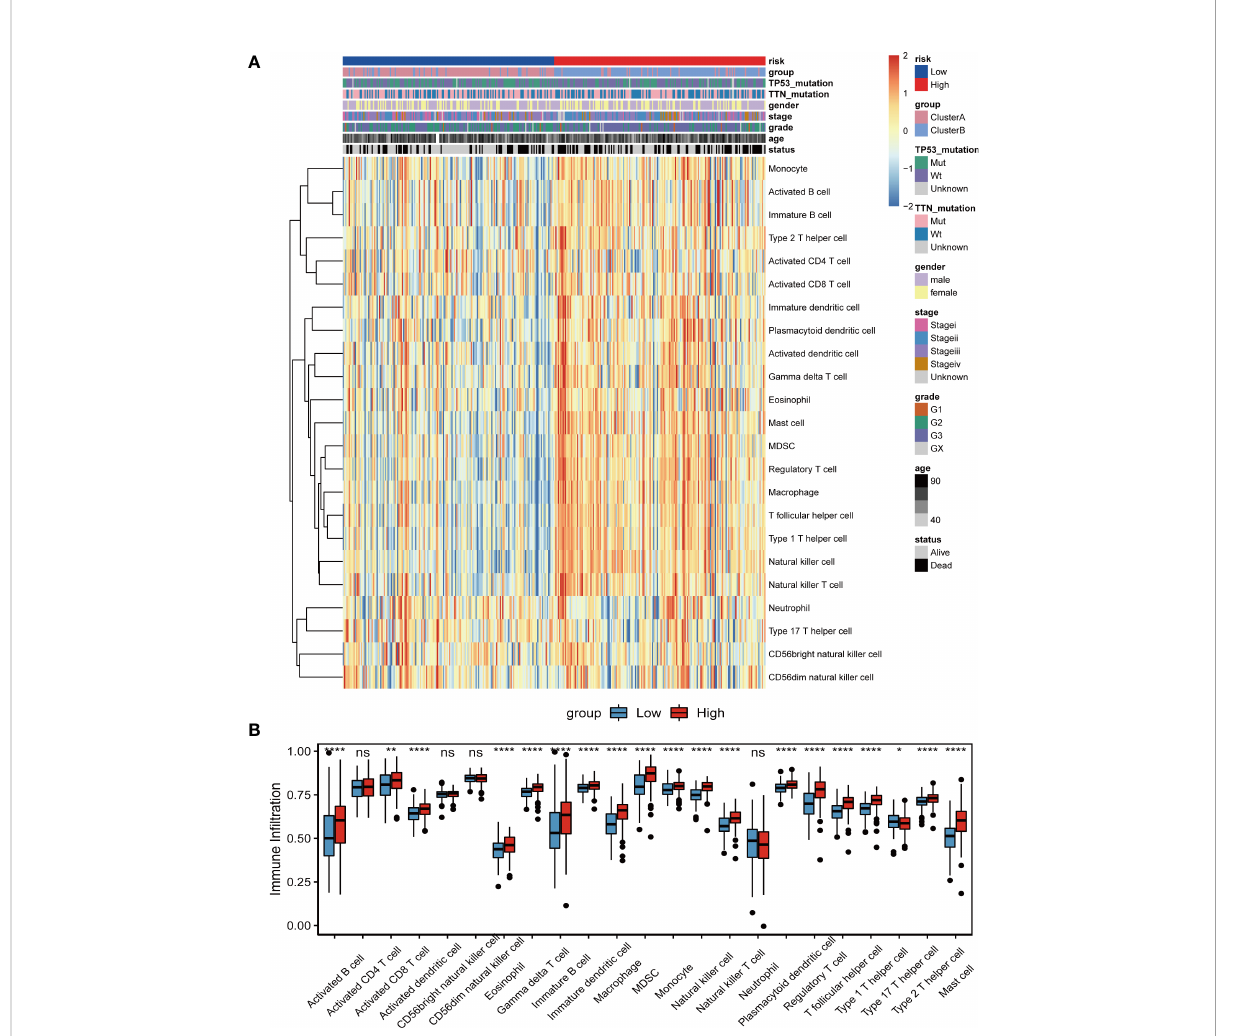
FIGURE 11 Relationship between tumor risk score and immune cell in fi ltration. (A) The distribution heat map of the proportion of immune cell in fi ltration between the high and low risk score groups; (B) The boxplot of the difference in immune cell in fi ltration between the high and low risk score groups. Differences between the two groups were analyzed using the independent t-test, values are expressed as the means±sem. ns, P>0.05; *P < 0.05; **P < 0.01; ***P < 0.001; ****P <